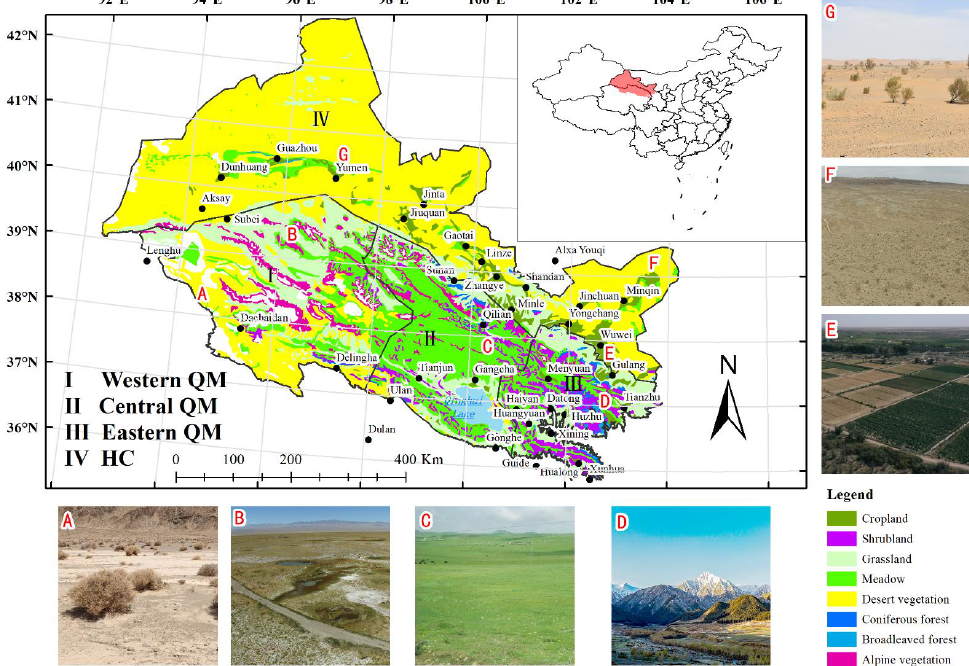
Figure 2. Spatial location, vegetation types, and zones of the study area. ( A – G ) shows the photos taken on the spot.